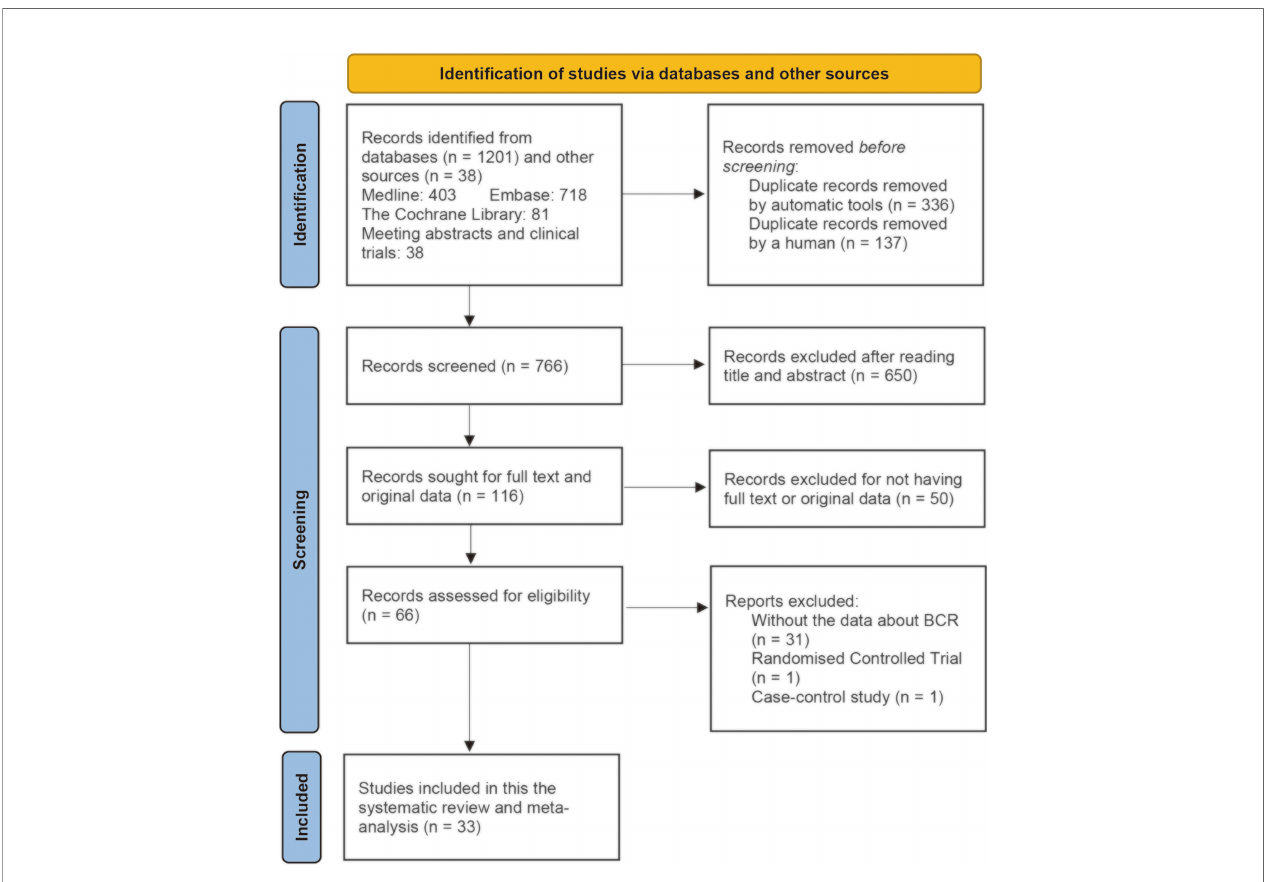
FIGURE 1 | PRISMA (Preferred Reporting Items for Systematic Reviews and Meta-Analyses) fl owchart for study selection for the systematic review on statins and clinical outcomes among patients with prostate cancer following de fi nitive